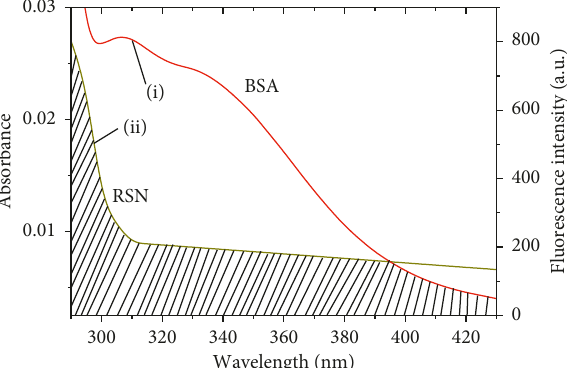
Figure 6: Overlap spectrum between (i) the fluorescence emission spectrum of BSA and (ii) the UV absorption spectrum of RSN. The concentration of BSA and RSN is 3 . 0 × 10 − 6 mol · L − 1 at 297K and pH